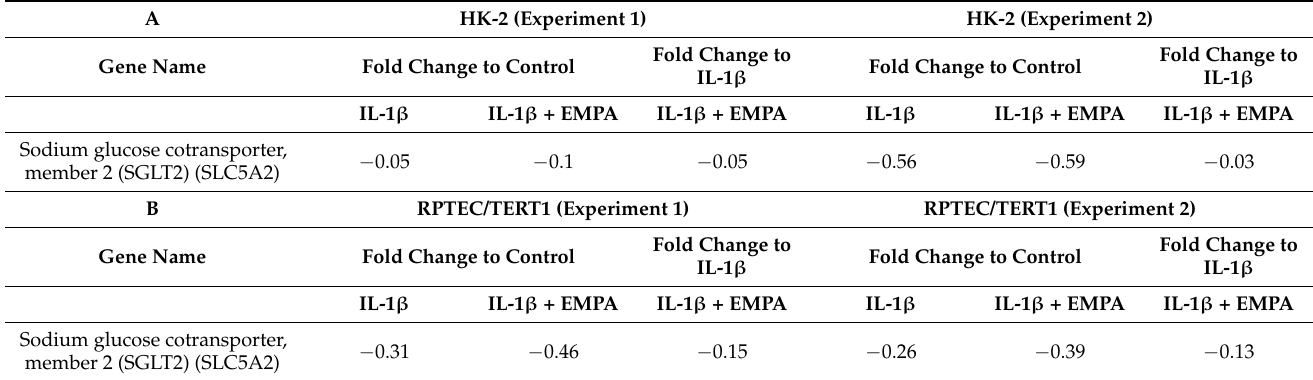
Table 2. Effect of empagliflozin (500 nM) on SGLT2 gene expression in IL-1 β (10 ng/mL)-stimulated HK-2 (A) and RPTEC/TERT1 (B)